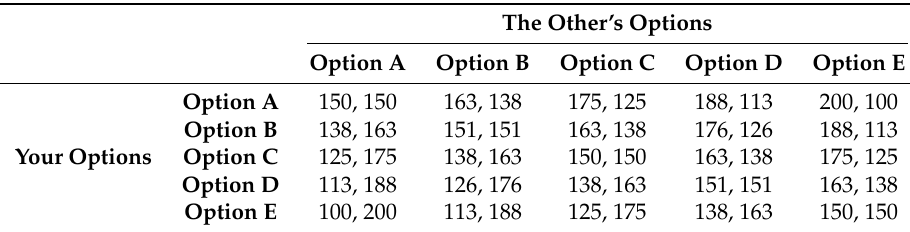
Table A6. Recomposition of task number five into a matrix game.